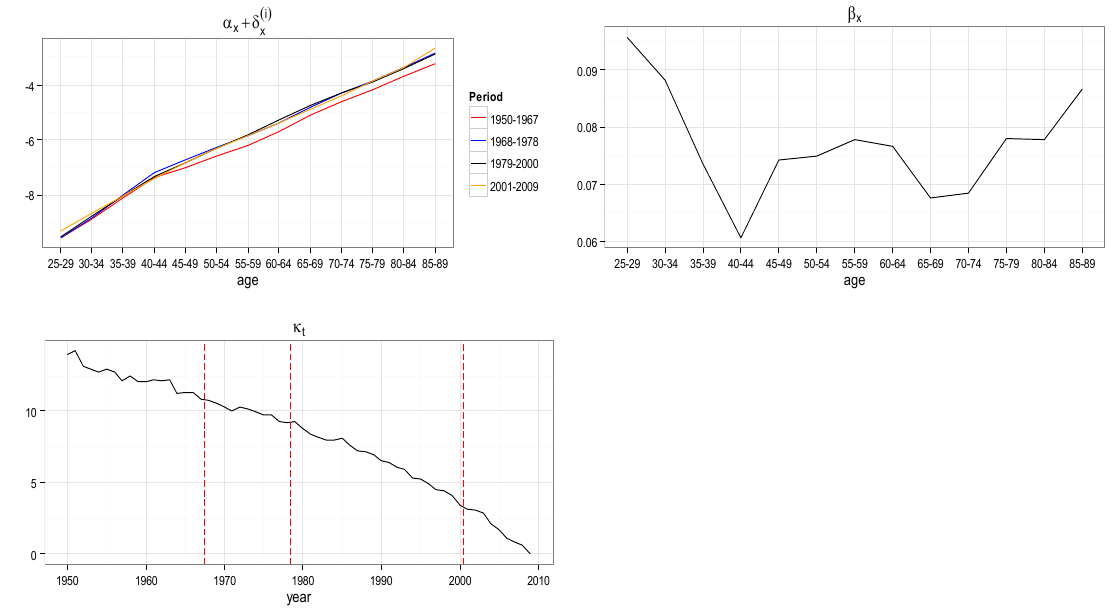
Figure 4. Model parameters, Cancer and Circulatory System Illness, UK Female population. On the axes of ordinates the parameter values.